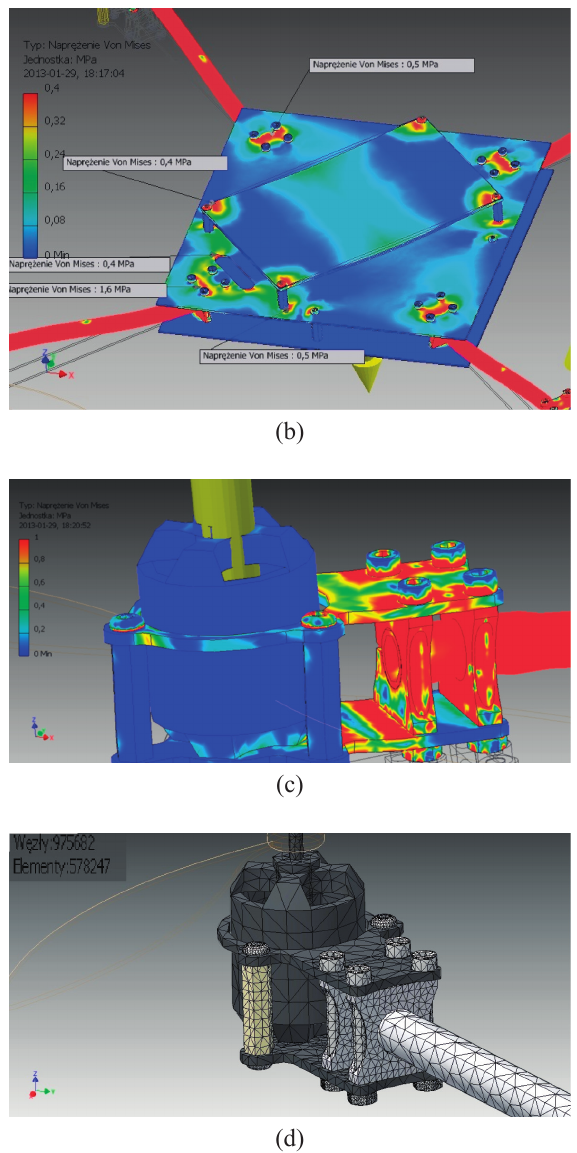
Fig. 3. Stress analysis of the quadrocopter’s: arms (a); main platform with additional plate for mounting electronics (b); basket mounting the engine (c); and its FEM discretization (d) Basically, the prototype design consists of three main parts: the platform, four arms and four engine mounting brackets. The parts during flight are illustrated in figure 4.